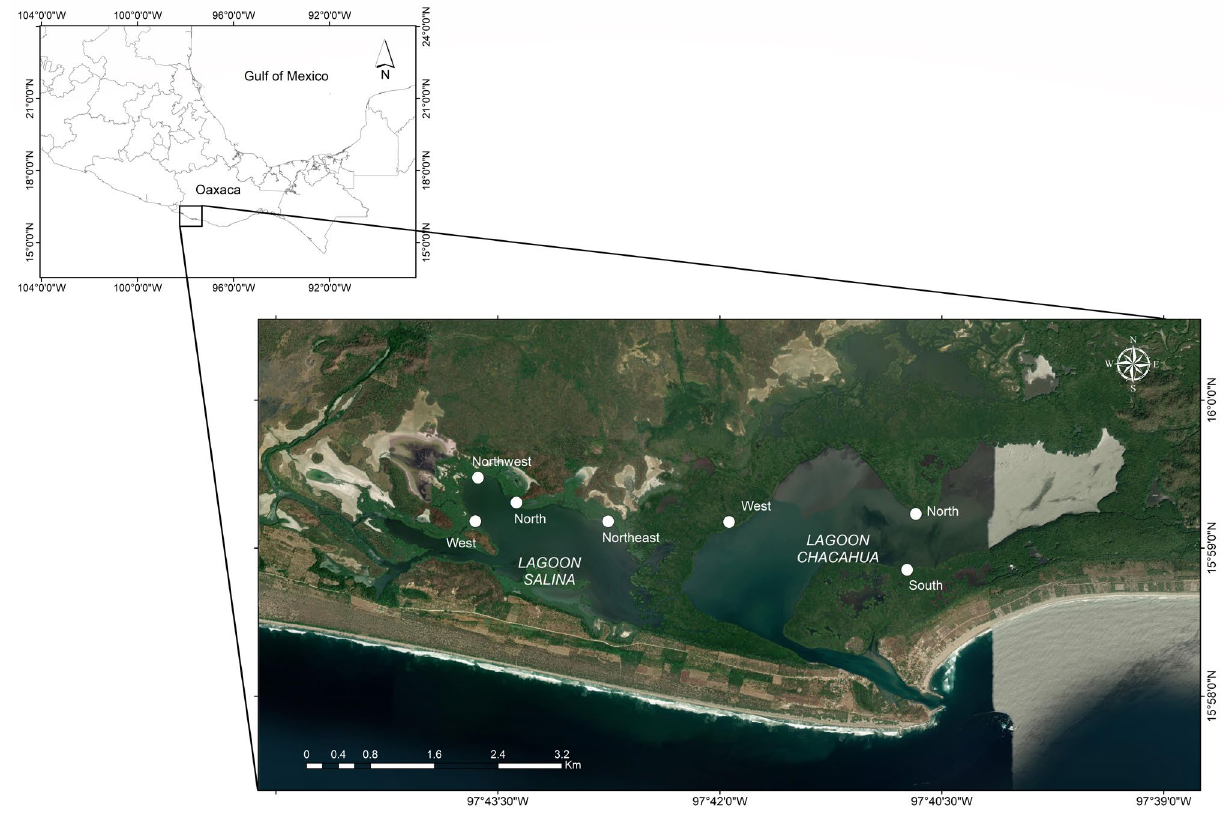
Figure 1. Study sites located in the Salina and Chacahua lagoons, Oaxaca, Mexico. Image prepared by the authors.